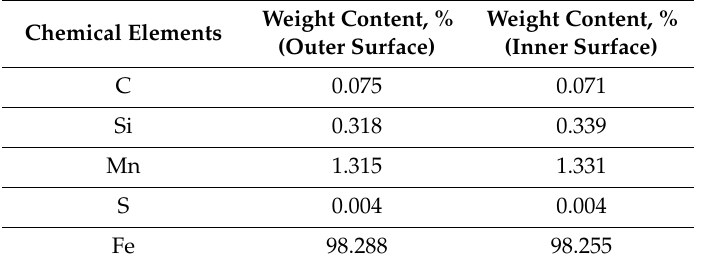
Table 6. Elemental composition of the outer and inner surfaces in the treated specimens.